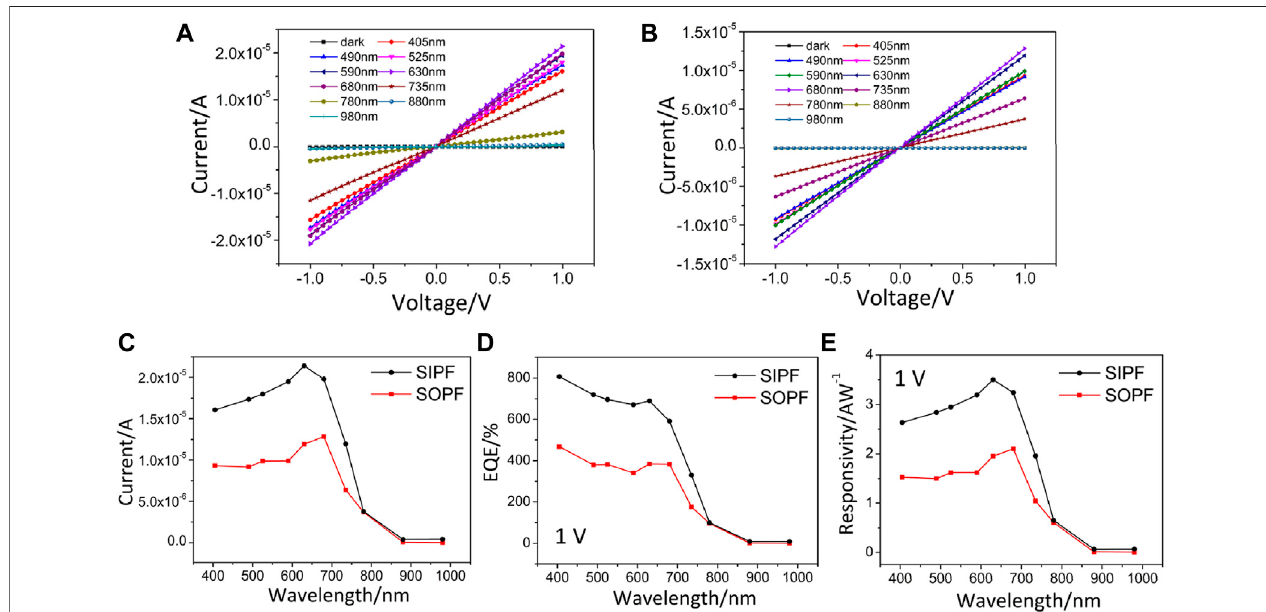
FIGURE 2 | Properties of the perovskite MAPbI 3 thin- fi lm PD. (A) I – V curves for the SIPF device. (B) I – V curves for the SOPF device. (C) Iph, (D) EQE, and (E) R comparison for the SIPF- and SOPF-based PDs.